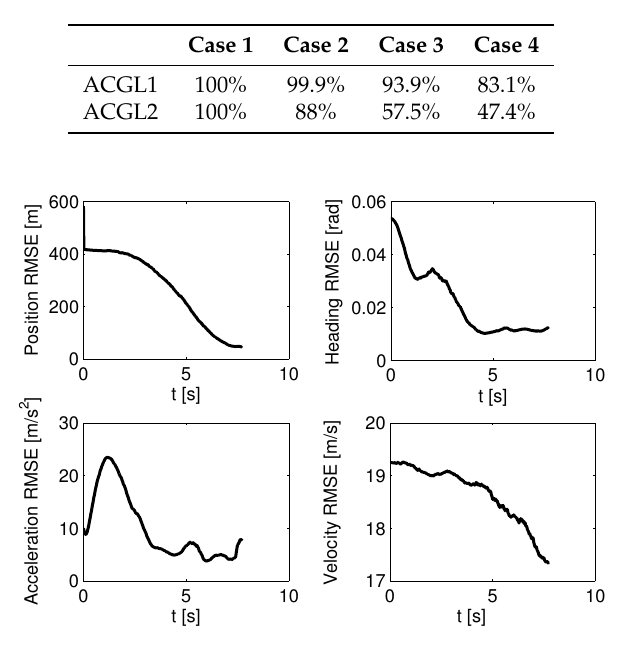
Figure 7. Estimation error of the sMME-SRCKF (static multiple model estimator with square-root cubature Kalman filter) in Case